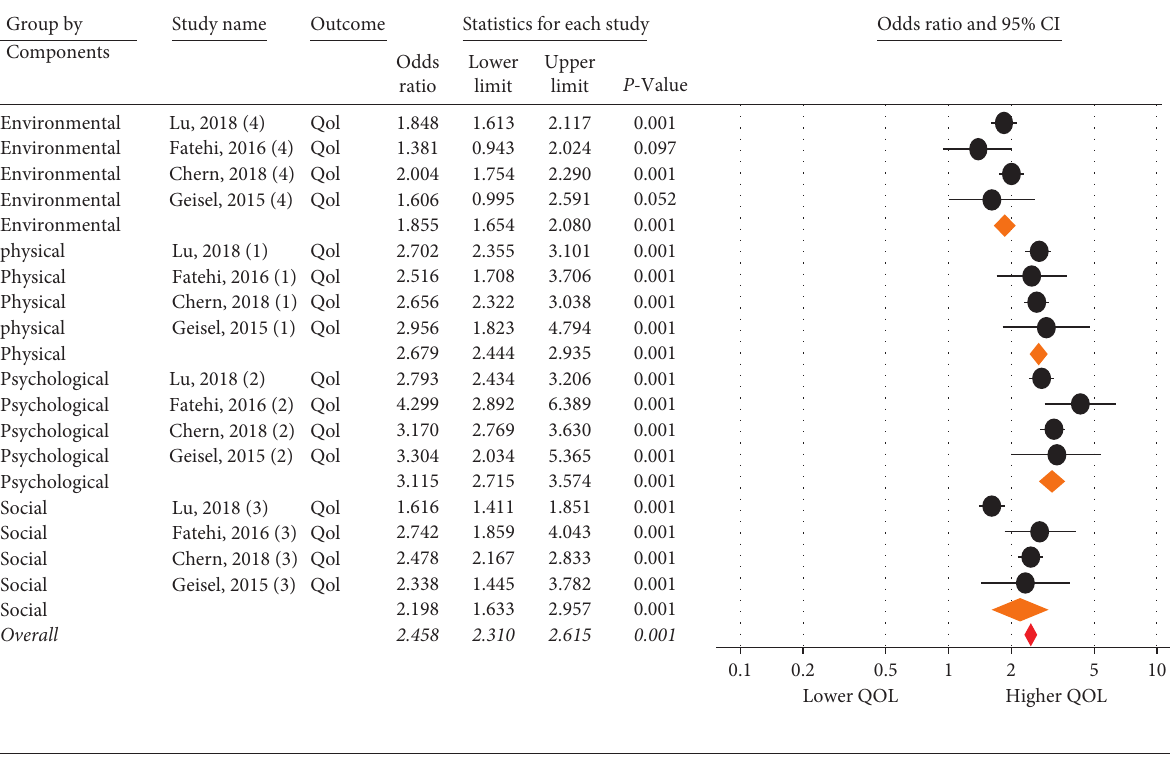
Figure 2: Comparing the quality of life of ordinary people with that of internet